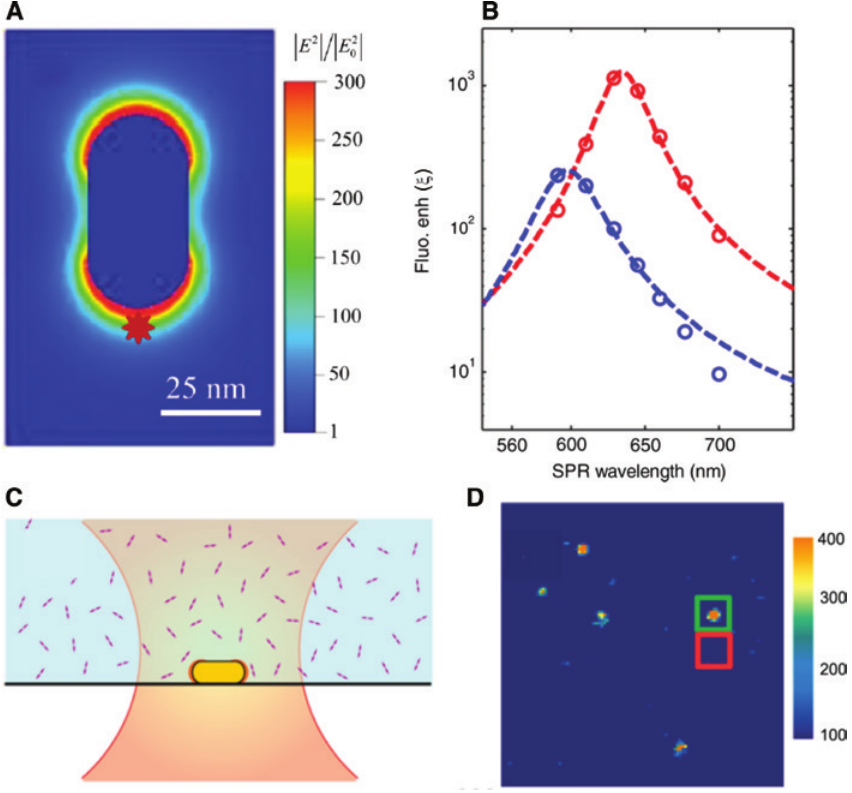
Figure 7: Metal-enhanced fluorescence in assemblies of Au nanorods and dye molecules. = 629 nm) measuring 47 nm in length and 25 nm in width. The excitation (A) Calculated near-field intensity map for an Au nanorod ( λ plasmon wavelength was set to 633 nm. (B) Fluorescence enhancement factors ( ξ ) versus the spectral position of the surface plasmon resonance. Excitation wavelengths were 594 nm (blue) and 633 nm (red). The distance between the molecule and the nanorod’s tip was 5 nm. (C) Simplified scheme of the experiment. (D) Typical one-photon PL image of individual Au nanorods. The excitation was at λ = 633 nm. Reprinted with permission from Ref. [20]. Copyright 2014 American Chemical